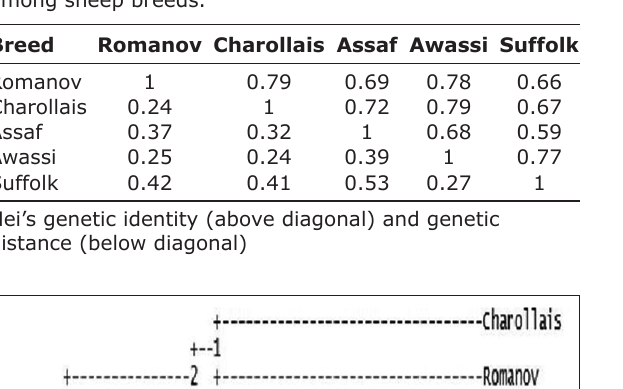
Table-4: Matrix of Nei’s standard genetic distances among sheep breeds. Breed